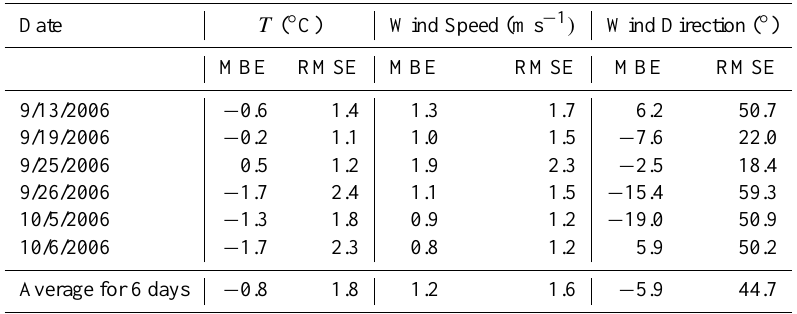
Table 2. Evaluation of the WRF-Chem model meteorology with measurements from 10 surface stations in southeast Texas for selected days. MBE denotes mean bias error and RMSE stands for root mean square error.